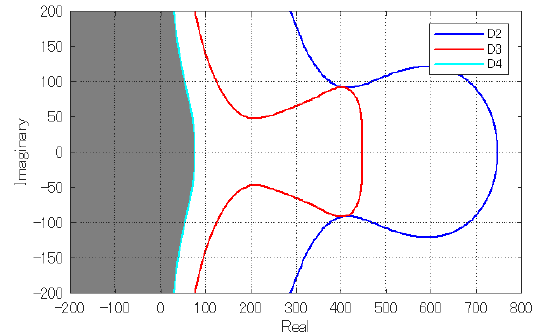
Figure 17. Simulation setting for evaluating wheel velocity control using DM-2.